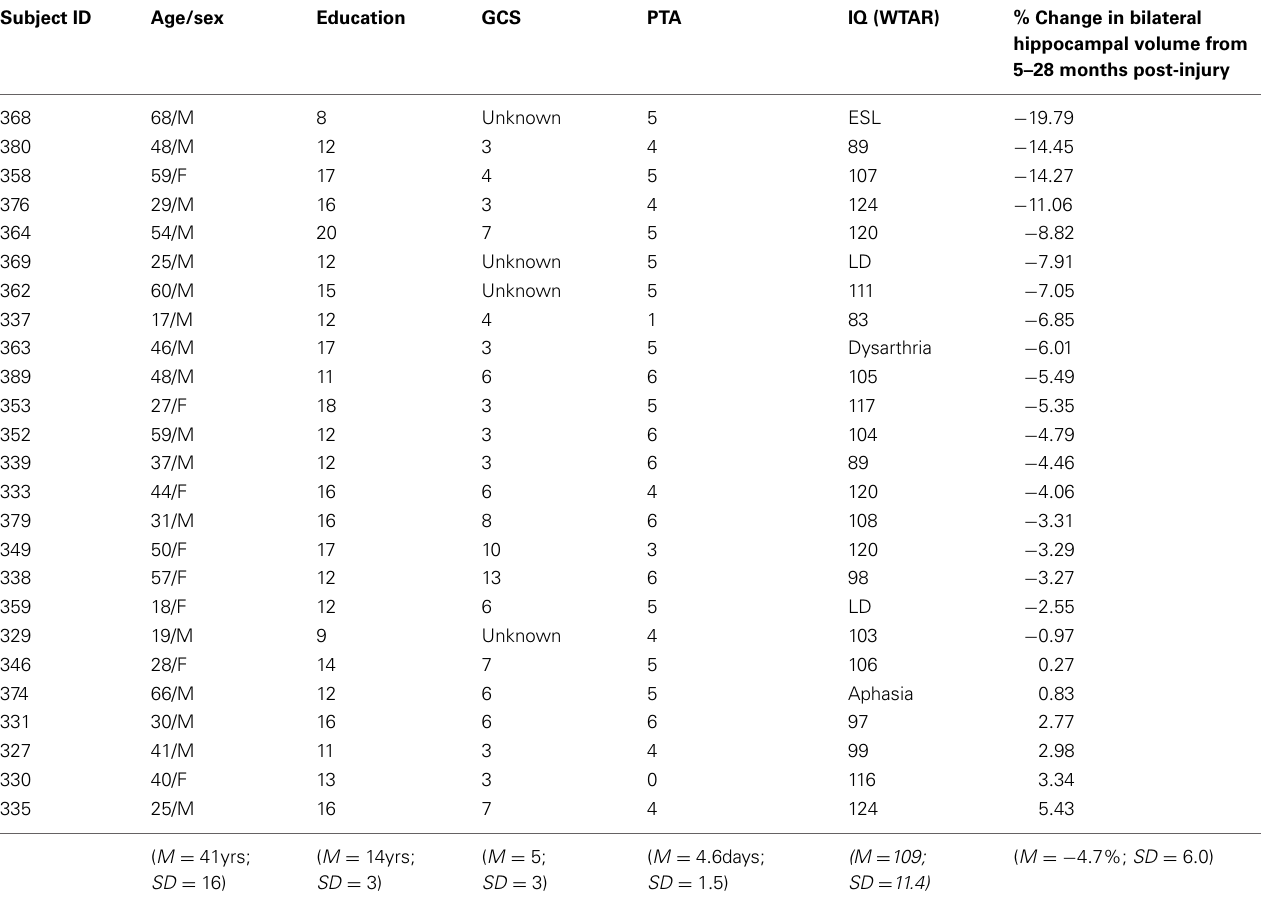
Table 1 | Demographic information and hippocampal volume